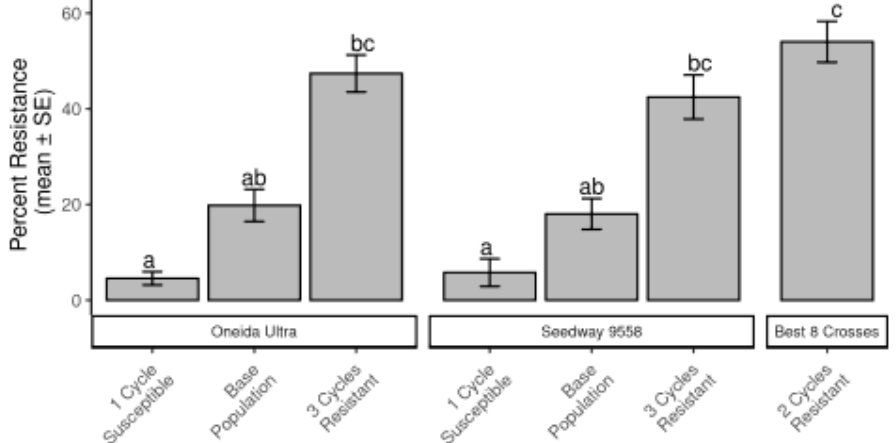
Figure 3. Comparison of alfalfa population mean ( ± SEM) percent resistance for populations result- ing from divergent selection within cultivars Oneida Ultra and Seedway 9558, and a population developed from the best eight plants selected from a field and intercrossed for CRC resistance for two cycles of selection. Different letters above bars indicate significant differences resulting from Tukey HSD.